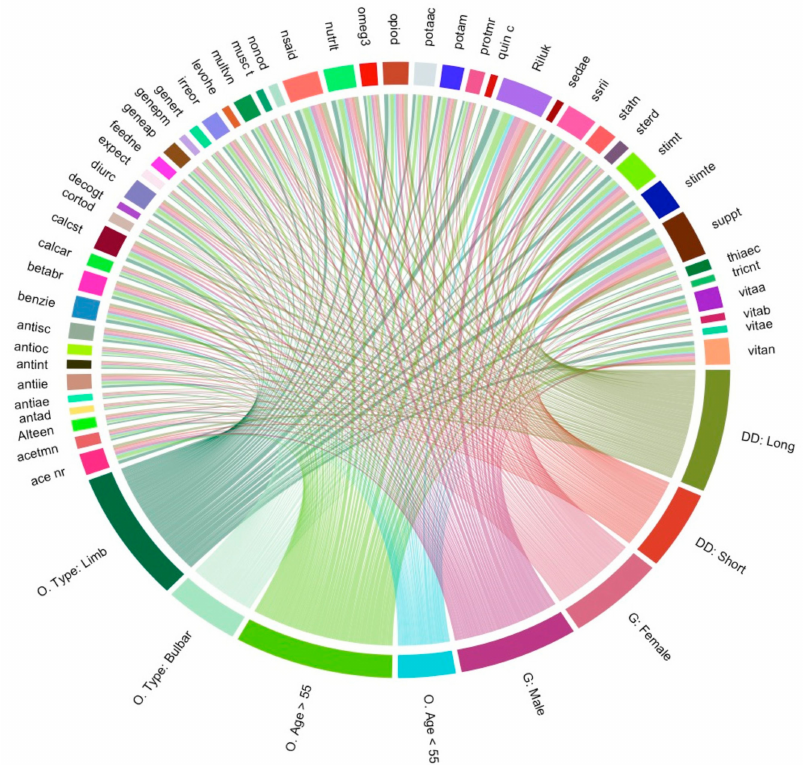
Figure 3. Correlation between the most common disease and intervention categories: “Most common” was defined as usage by more than 8.5% of the ALS cohort (see Methods). On the circular relationship plot, each 1-pixel line illustrates a patient connection. Gender (G) is replaced by “male” or “female”, onset type (O) is replaced with “bulbar” or “limb”, onset age (O. Age) is replaced with “ ≥ 55 years” and “ < 55 years”, disease survival duration (DD) is replaced with “longer” or “shorter” (than the average disease duration, which is equal to 3.67 years for this analysis). Other shorthand symbols are defined in detail in Table